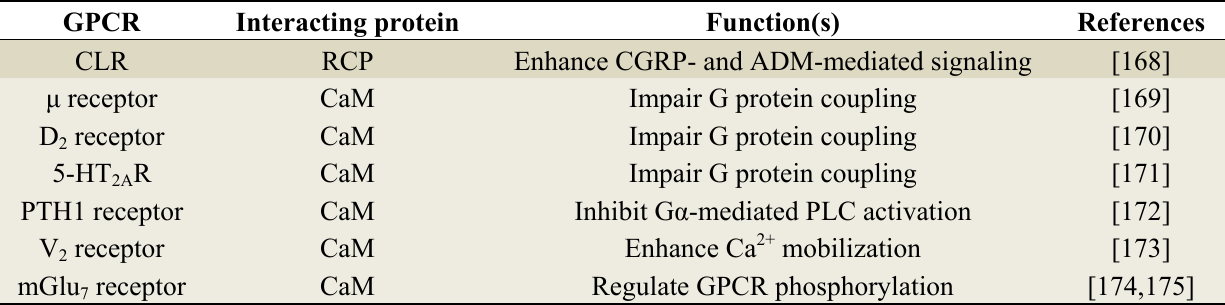
Table 3. Interacting proteins that influence signaling of